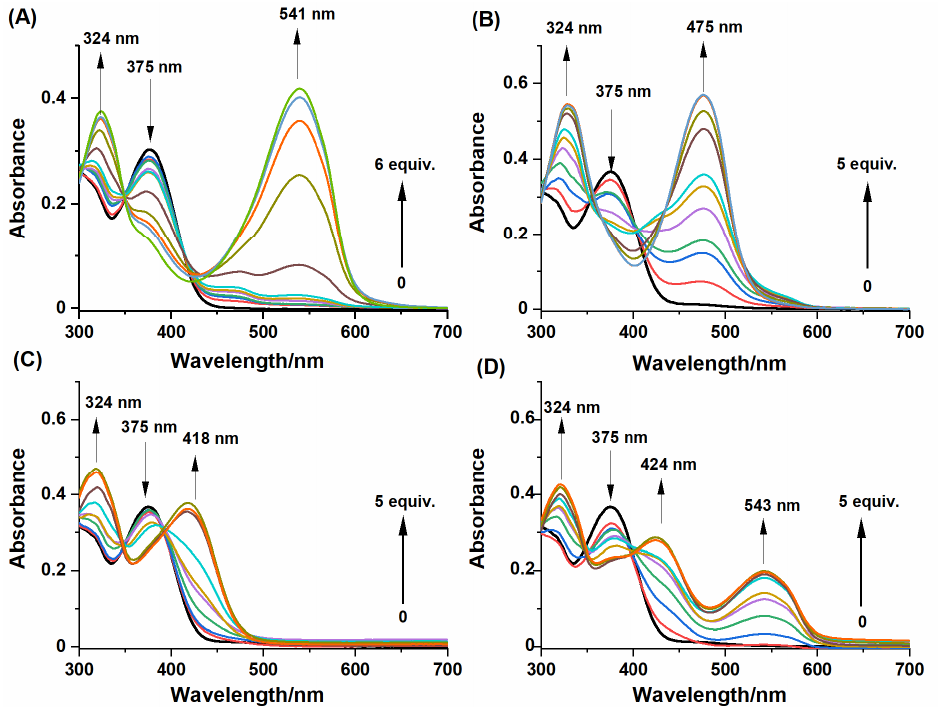
Figure 2. Absorption spectral changes of NBD-O-CmCH 2 OH (30 μ M) responses to various concen- trations of ( A ) Na 2 S (0–180 μ M); ( B ) L-Cys (0–150 μ M); ( C ) GSH (0–150 μ M), ( D ) NAC (0–150 μ M) in